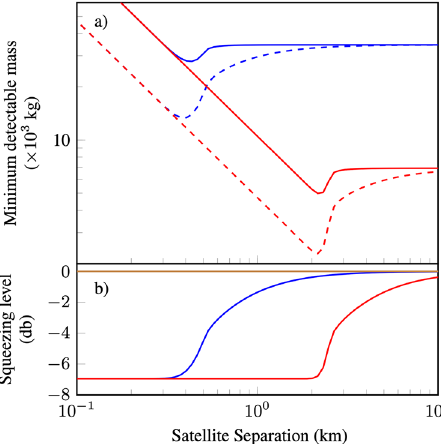
Fig. 7 Minimum detectable mass for quantum noise limited geodesy. a The bene fi t from using squeezed light is obtained within the satellite separation where diffraction losses are not signi fi cant. This distance can be extended by increasing the aperture of the receiving optics. The blue and red lines correspond to receiving optics with aperture radius of 5 and 25 cm, respectively. Dashed lines indicate the point mass sensitivity using squeezed light. Parameters used are input power P 0 = 25 mW and initially 7 dB of pure squeezing. b Effective squeezing level as a function of satellite separation. Brown line corresponds to the quantum noise level.